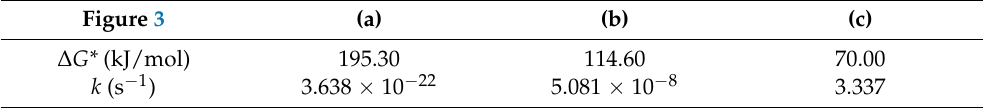
Table 2. Activation energy ( ∆ G* ) and dissolution rate constant ( k ) computations of light gray Ca dissolution from 100 or 100 facets at the room temperature according to Figure 3.